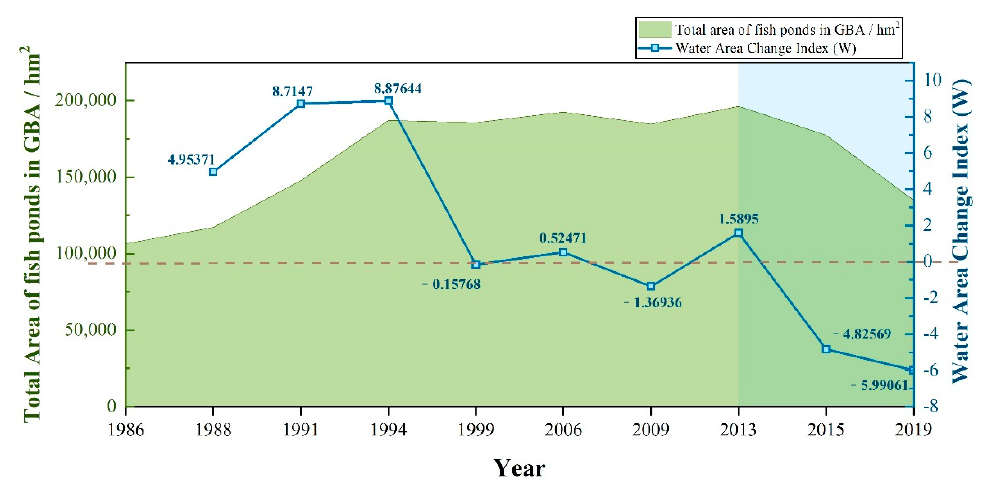
Figure 8. Water area change index and pond areal fluctuation in the GBA from 1986 to 2019.